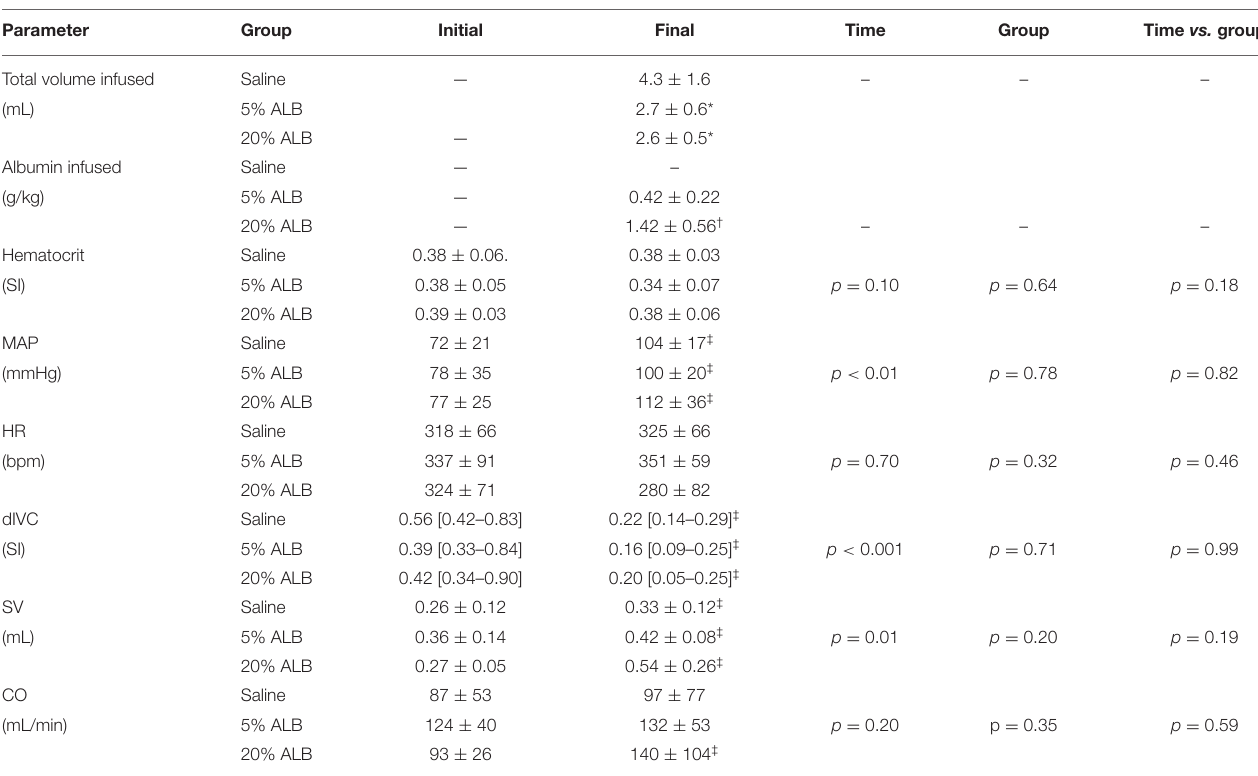
Data are shown as mean ± SD; 20% ALB, 20% albumin; 5% ALB, 5% albumin. Comparisons among groups at each time point (INITIAL and FINAL) were done by two-way ANOVA followed by Holm–Šídák’s multiple comparisons. For comparison of total volume infused, the Kruskal–Wallis test with Dunn’s multiple comparisons was used. For comparison of albumin volume infused, the Mann–Whitney U-test was used. MAP, mean arterial pressure; HR, heart rate; dIVC, distensibility index of the inferior vena cava; SV, stroke volume; CO, cardiac output; SI, International System of Units. * vs Saline (p < 0.05); † vs 5% ALB (p < 0.01); ‡ vs Initial (p <